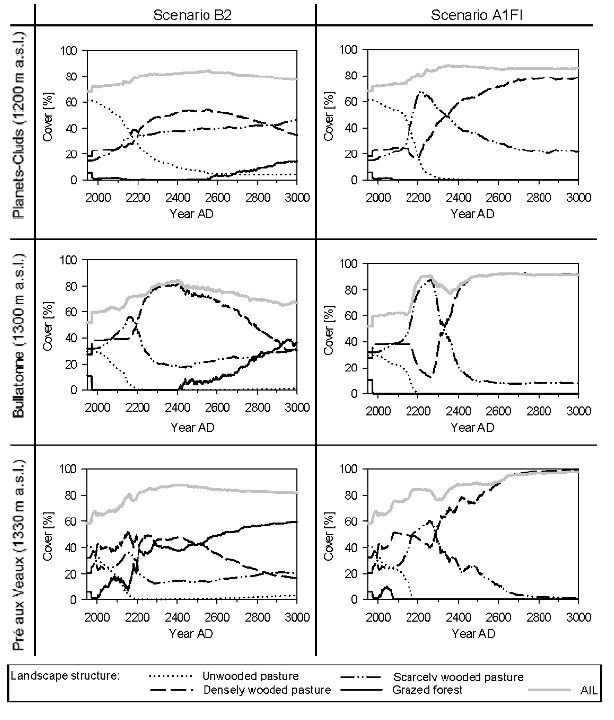
Fig. 7 . Landscape structural dynamics following climate change in the wooded pastures Planets-Cluds, Bullatonne, and Pré aux Veaux (m a.s.l. = meters above sea level). The four phytocoenosis types used for display are defined in Table 3. The pasture Rionde was not simulated because it is located at the same altitude as Pré aux Veaux. The landscape aggregation index AIL is defined in the caption of Fig. 5.